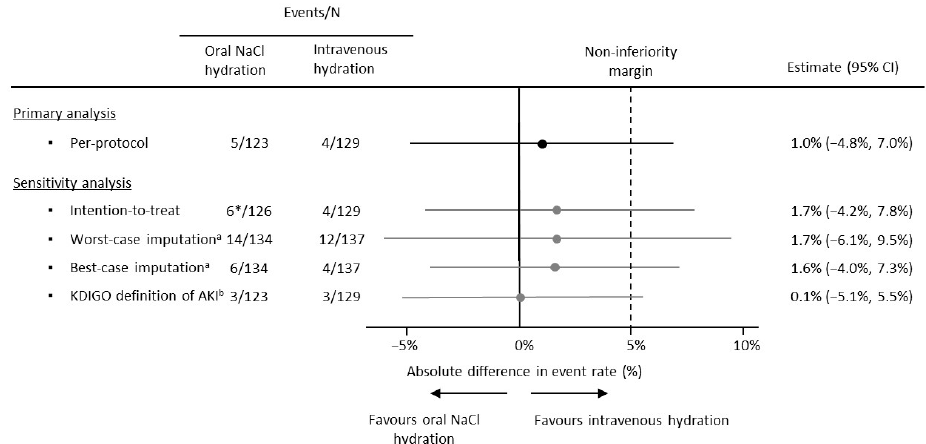
Figure 2. Forest plot of the main outcomes (primary and sensitivity analyses). The results are given as absolute risk differences (black points) with a 95% confidence interval (black line) for the primary outcome (i.e., decrease in eGFR [MDRD-4] > 25% or increase in serum creatinine > 0.3 mg/dL, within 48h after CE-CT scan). The non-inferiority of oral hydration would be shown if the upper limit of the 95% CI of the absolute risk difference between the groups was less than 5% (non-inferiority margin, indicated by the black dashed line). The 95% confidence interval for the difference between the two independent proportions was calculated according to Wilson’s method. * A primary event took place in a subject excluded from the per-protocol analysis due to a lack of adherence to the oral treatment. a Sensitivity analyses were performed on the intention-to-treat population, with missing outcome data imputed as if all (worst case) or none (best case) of them had a primary outcome. b Non-inferiority analysis was repeated, considering as the main outcome the definition of acute kidney injury (AKI) proposed by the Acute Kidney Injury Working Group of KDIGO (Kidney Disease: Improving Global Outcomes), meaning an increase in serum creatinine ≥ 0.3 mg/dL or 1.5 times the baseline, within 48 h after iodinated contrast [19]. Table 2. Differences in continuous efficacy assessments between oral- and intravenous-hydration groups within the 48-h follow-up period in the per-protocol population.